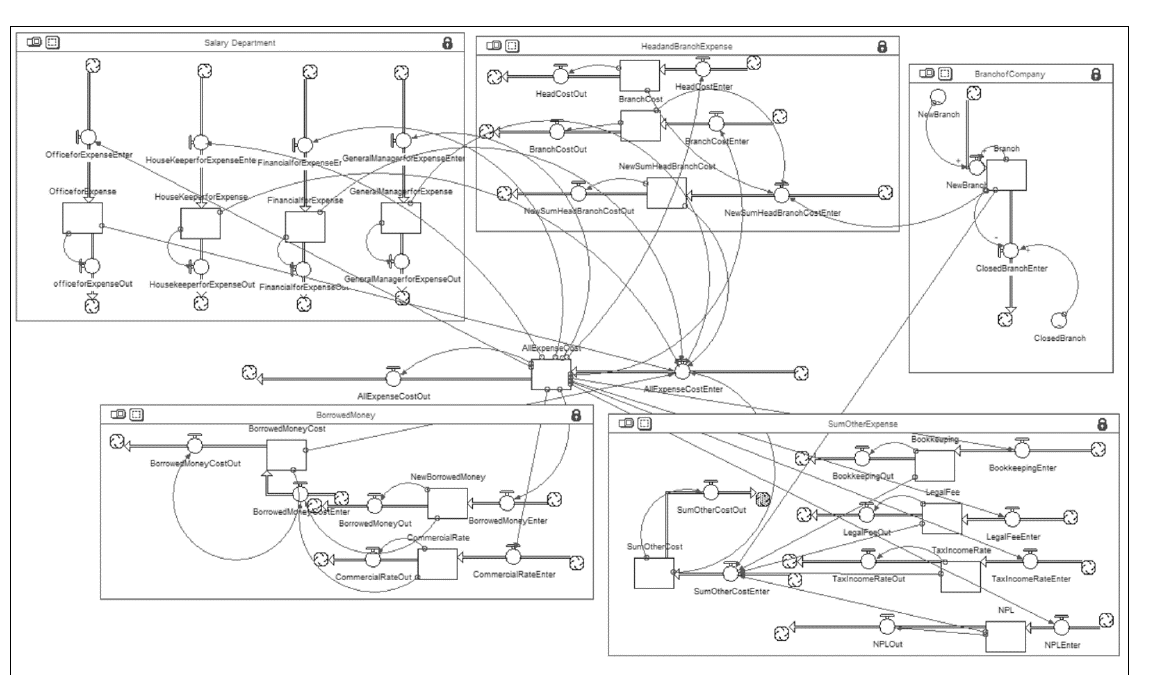
Figure 5. Expense model by system